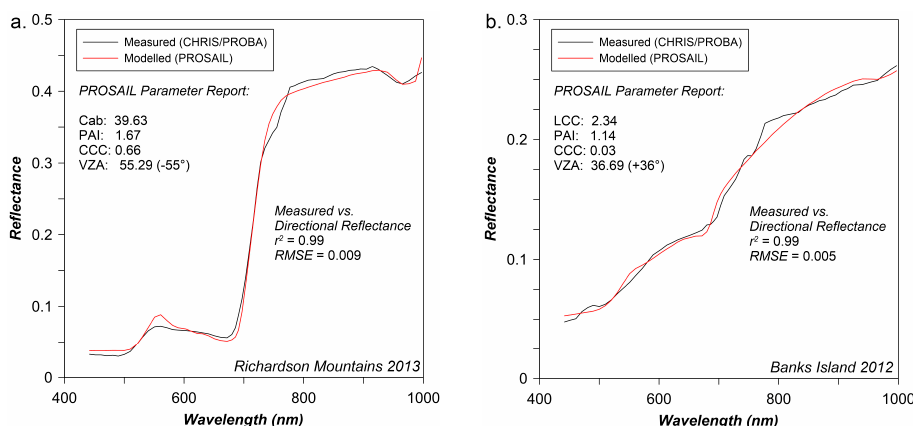
Figure 8. Examples representing the range of measured and modelled top-of-canopy (TOC) spectral-directional reflectance curves for: ( a ) Richardson Mountains (2013) with more dense vegetation cover (view zenith angle, VZA = − 55°); and ( b ) Banks Island with sparse vegetation cover (VZA = +36°).